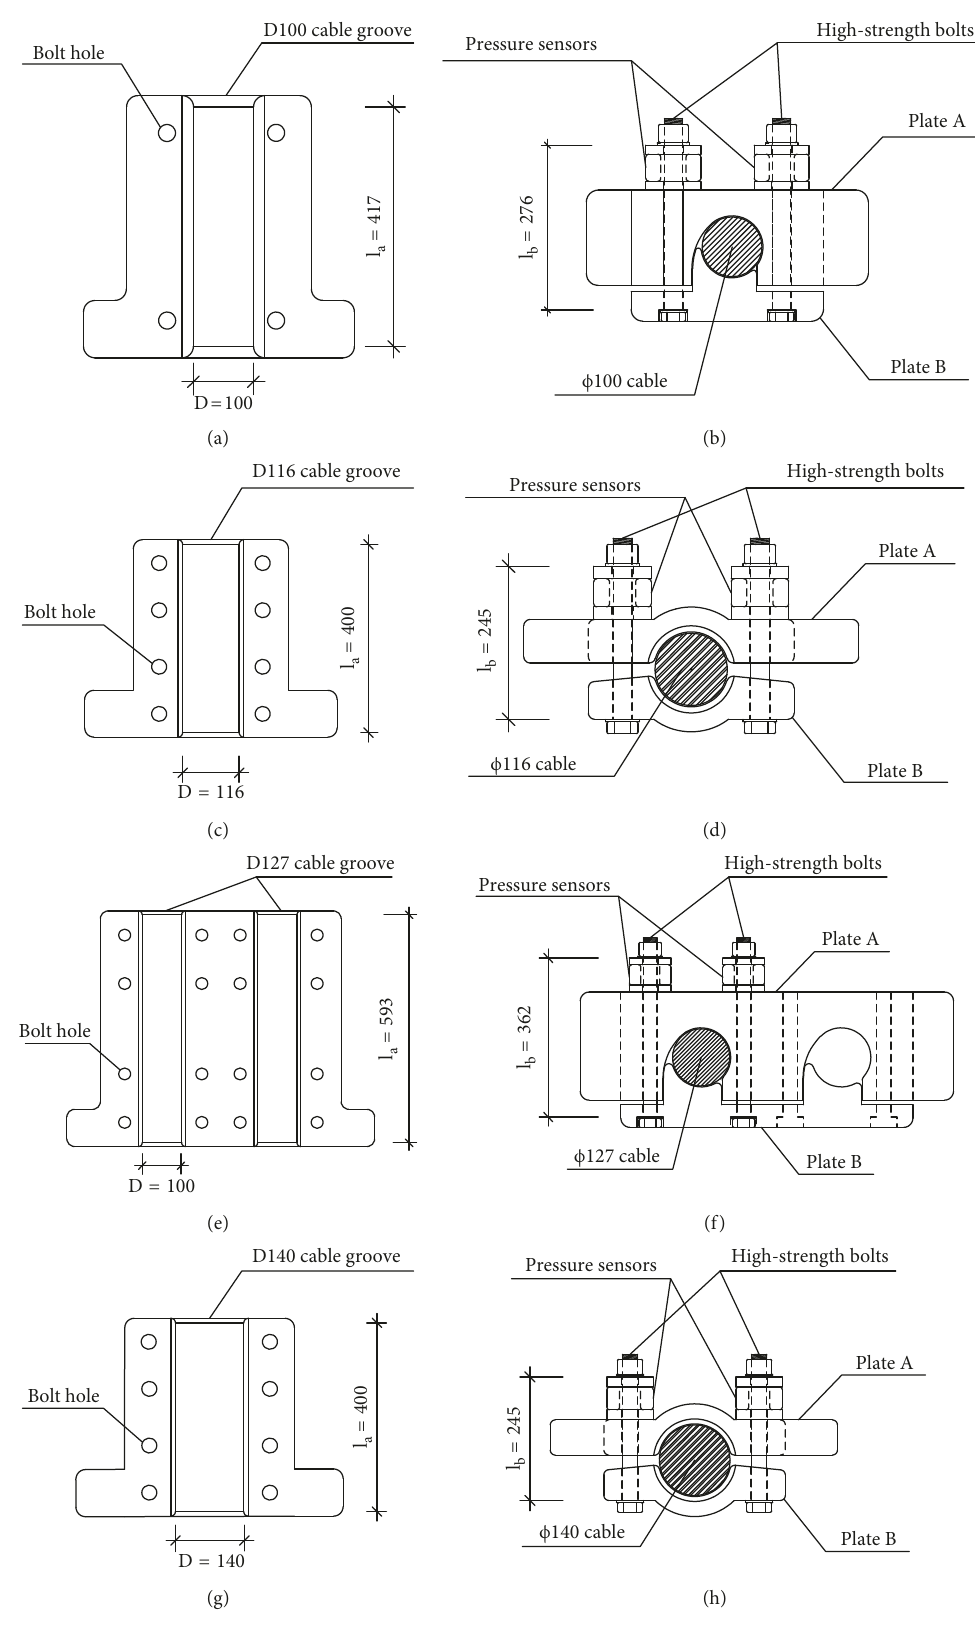
Figure 11: Test specimens of cable clamp. Top view of the (a) cable clamp. Cross-sectional view of the